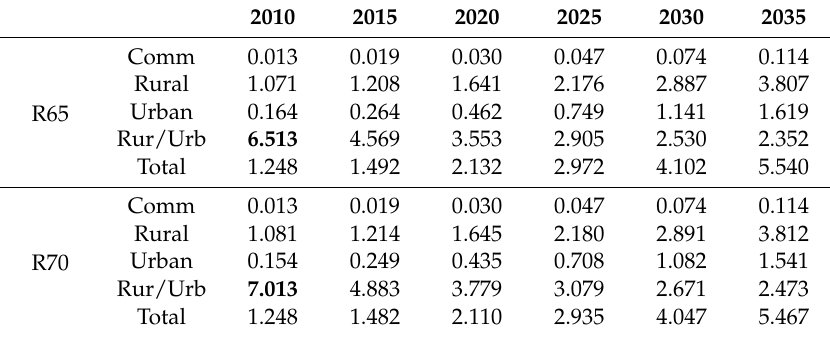
Table 8. Energy Consumption by Different Urban vs. Rural Energy Consumption Rate,